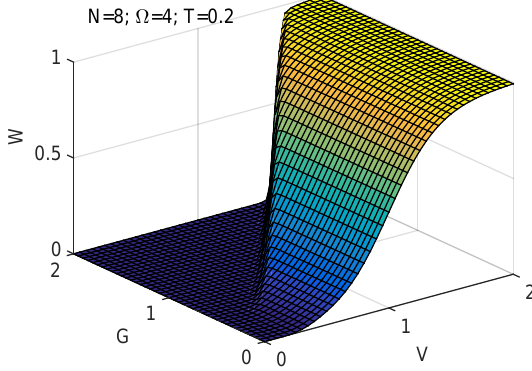
Figure 8. 3D study. The N dependence. Monopole activity-indicator W versus V and versus G . N = 8 and T = 0.2. Growing pairing works against W , more strongly for V < V crit